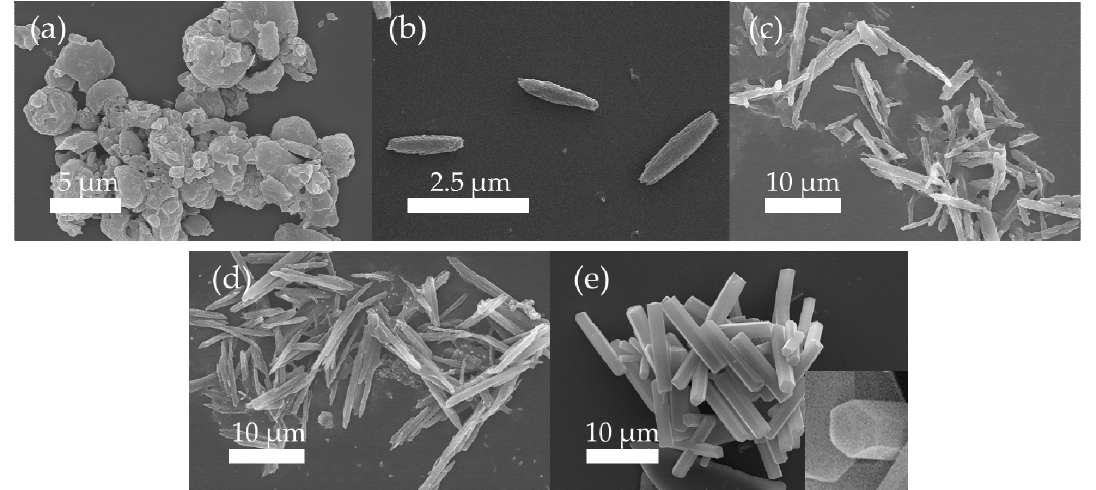
Figure 2. Morphological analyses of Alq 3 MCs. ( a–e ) SEM images of Alq 3 MCs after assembly with